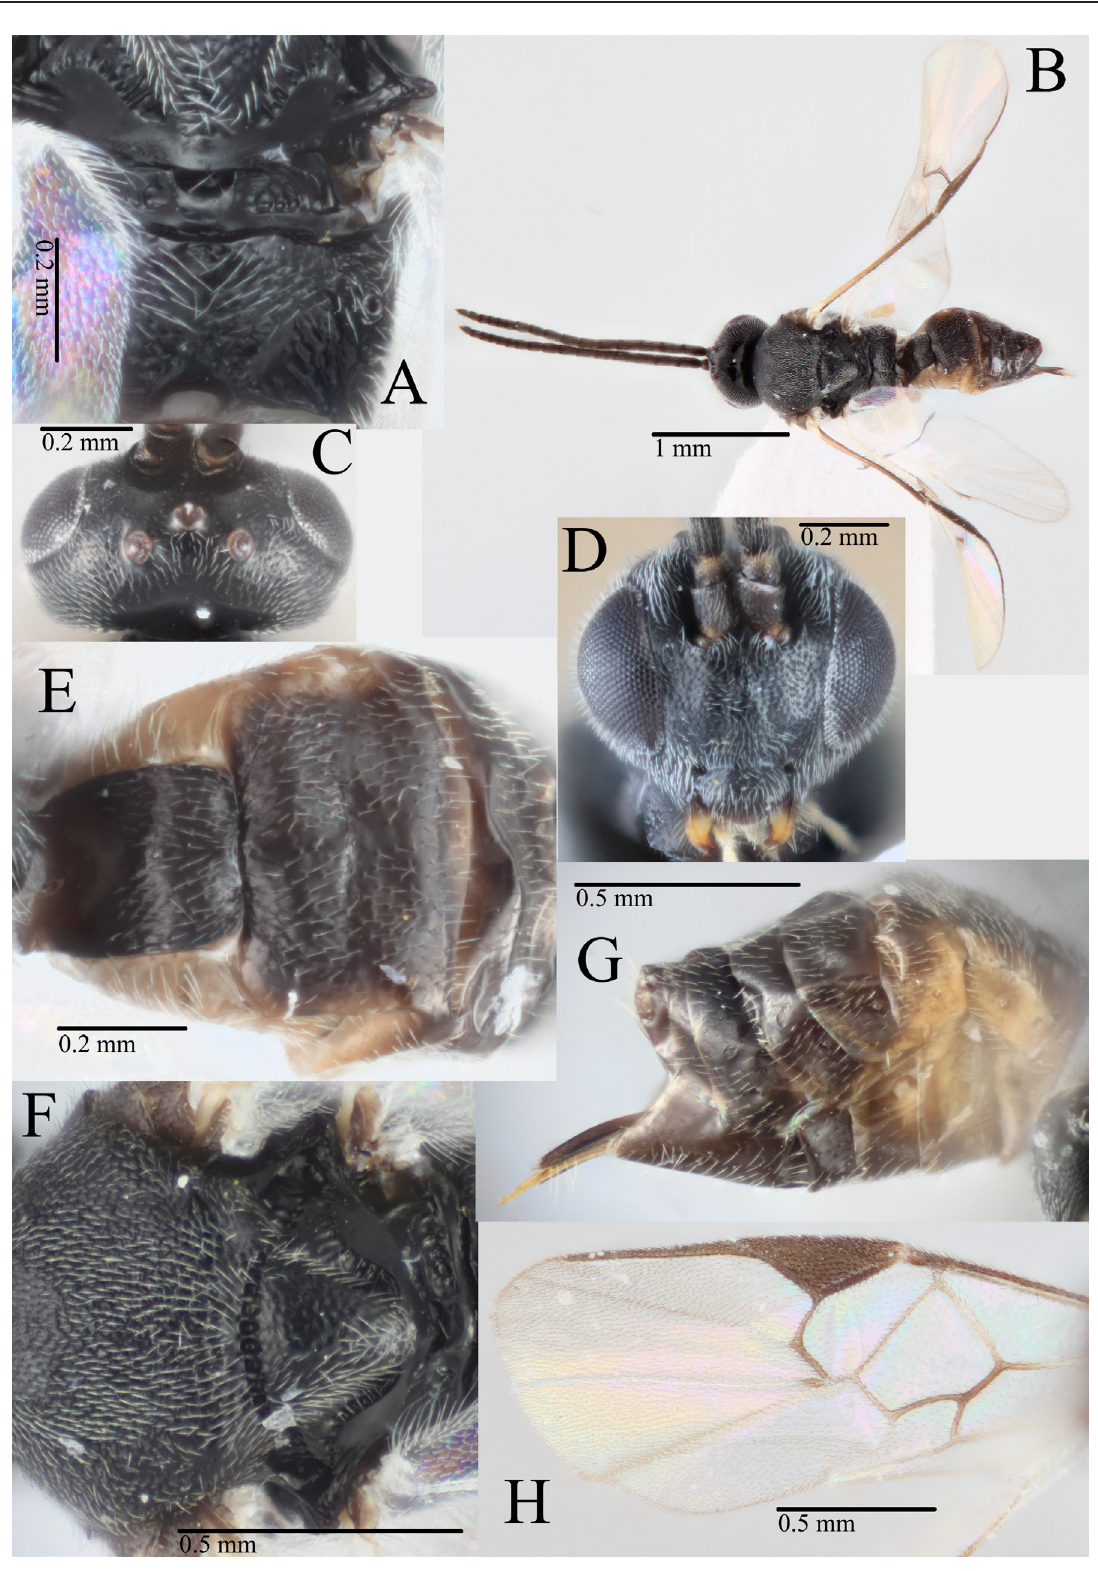
Fig. 19. Cotesia lasallei sp. nov., holotype, ♀ (SAMA 32-44401). A . Mesoscutellum and propodeum. B . Habitus in dorsal view. C . Head in dorsal view. D . Head in anterior view. E . Metasoma in dorsal view. F . Anteromesoscutellum and scutellar disk. G . Metasoma in lateral view. H .